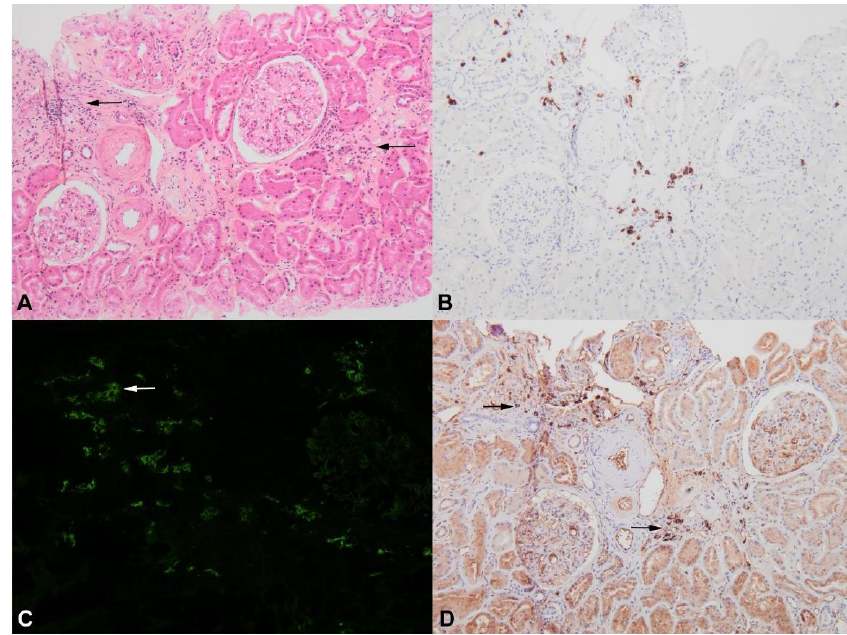
Figure 4. Minimal interstitial infiltration (arrows) by few tumoral lymphocytes and plasma cells (( A ), hematein eosin saffron ×100), displaying CD79a positivity (( B ), ×100) and monotypic staining for IgM (( C ), ×100, arrow) and lambda light chain (( D ), ×100, arrows).